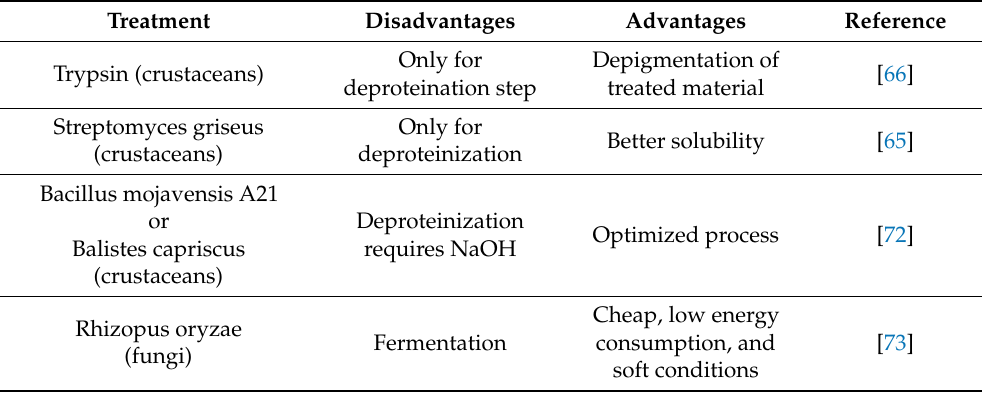
Table 3. New methods for the production of chitosan.